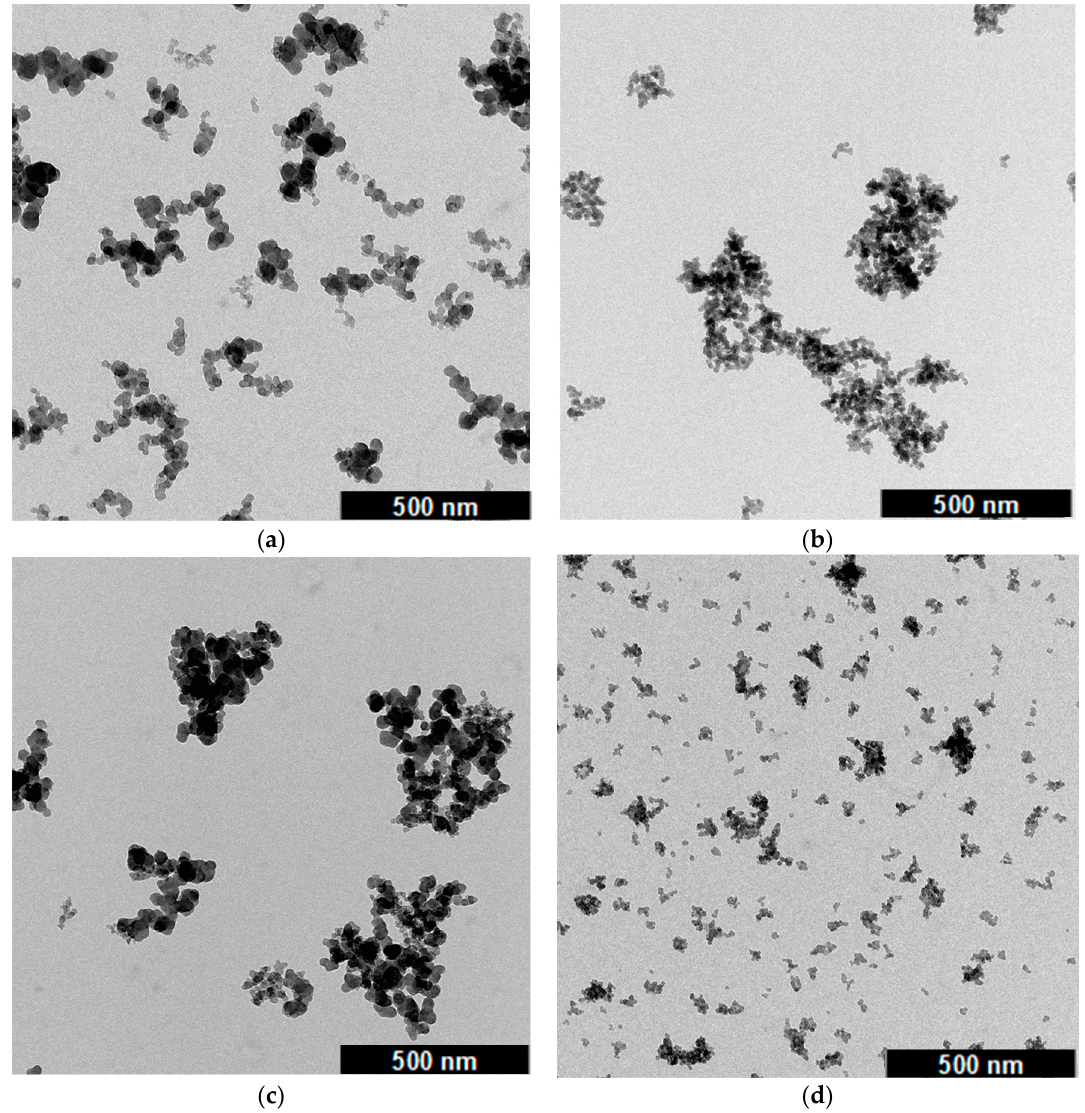
Figure 9. TEM images of carbon black N330 ( a ) and silica 158GR190 ( b ) in their initial form and carbon black ( c ) and silica ( d ) after compression with 125 MPa at a magnification of 20.000.